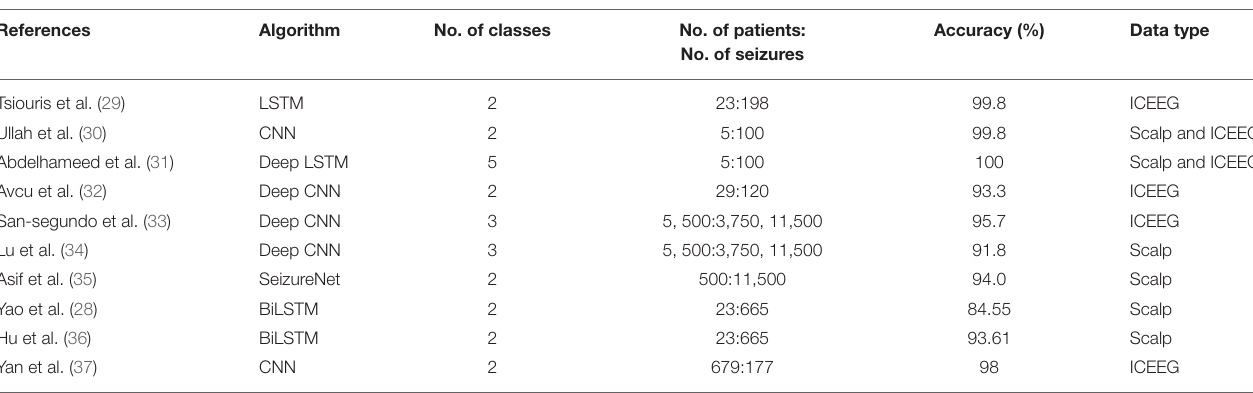
TABLE 3 | Summary of prior studies evaluating deep learning for seizure